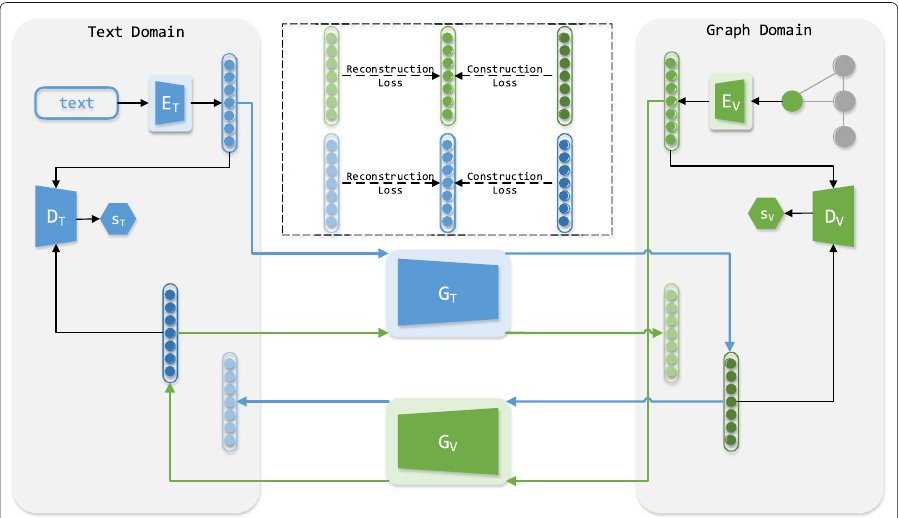
Fig. 2 Illustration of the SRGAN framework. E T and E V are the domain encoders to pretrain the embedding spaces. s T and s V are the scores which evaluate the likelihood of the transformed data to be the target one. The light blue and light green embeddings are the reconstructed data, while the dark ones are the transformed data. The blue arrows denote the text-node-text data flows, while the green ones denote the node-text-node data